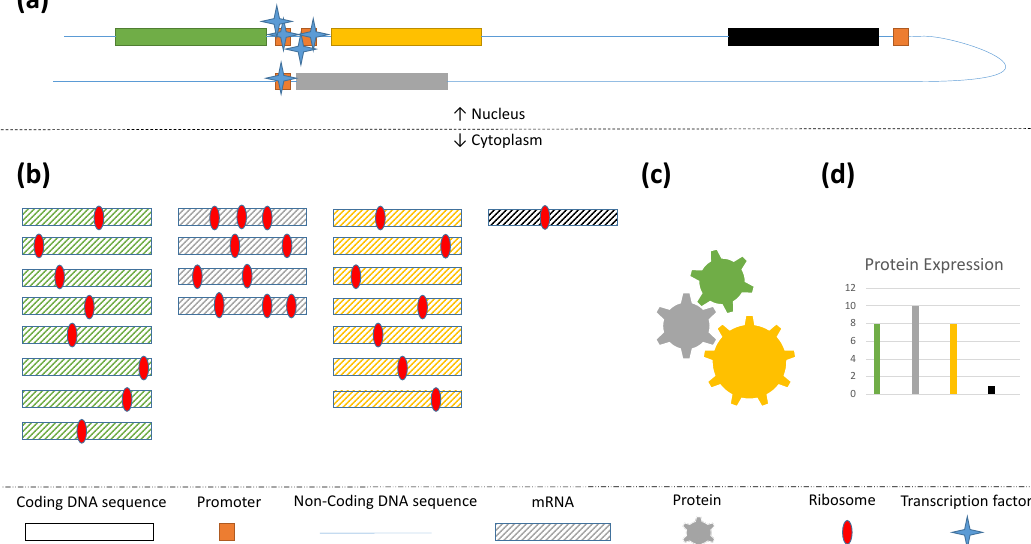
Figure 4. Genes that are close to each other in space are likely to be co-expressed, because transcription factors that bind on a promoter are likely to also bind to nearby promoters ( a ). Differences in expression are indicated by the amount of transcripts in the cytoplasm ( b ). In this case the green, yellow and gray genes code for proteins (shown as gears of the same color) that form a protein complex and perform a function together ( c ). The ribosome occupancy of the mRNAs is used to indicate differences in translation efficiency which result in similar abundances for proteins ( d ) despite different mRNA